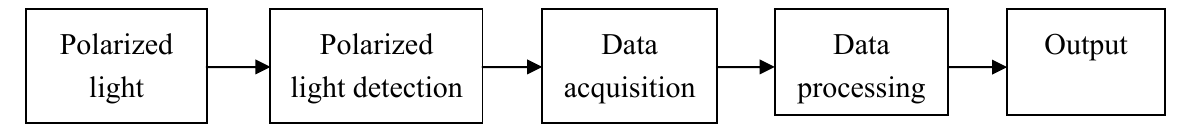
Figure 4. Simple block diagram of polarization navigation sensor